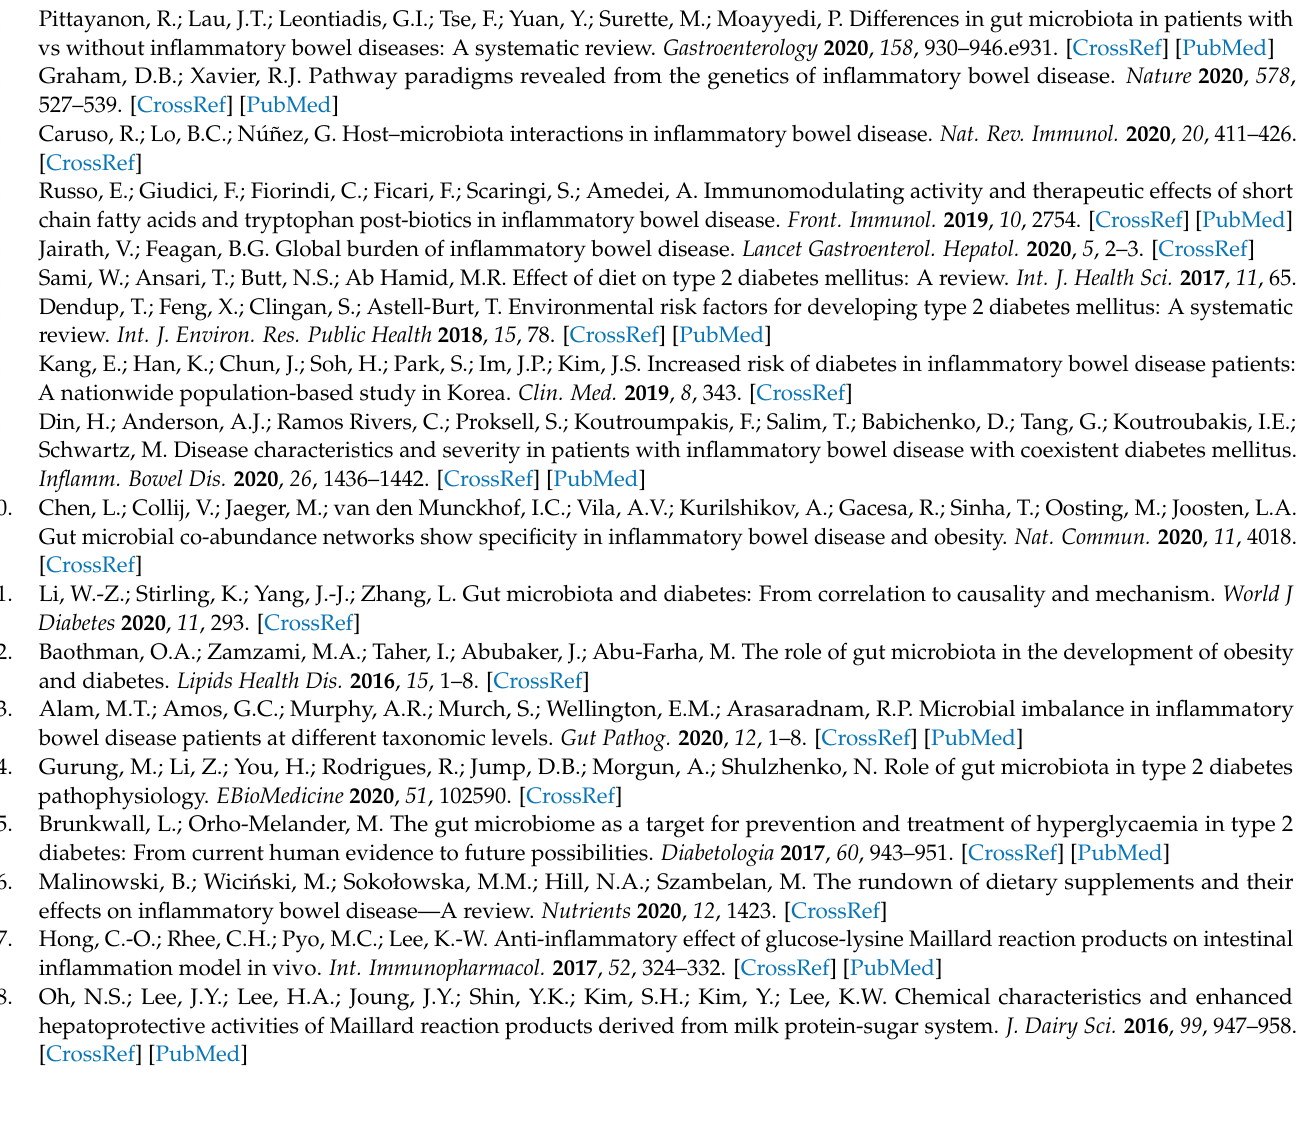
Figure S2: Microbial community analysis of cecal samples in colitis induced DB/DB mice. Figure S3. Levels of short-chain fatty acids (SCFAs) in the cecal